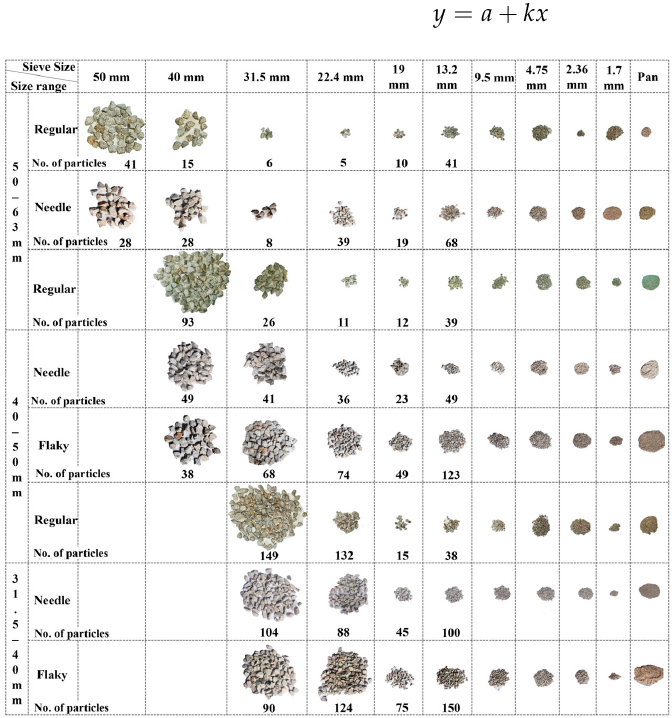
Figure 10. Photos of particle-size-degradation trends of distinctly shaped single-size ballasts upon the completion of 60 impact-load